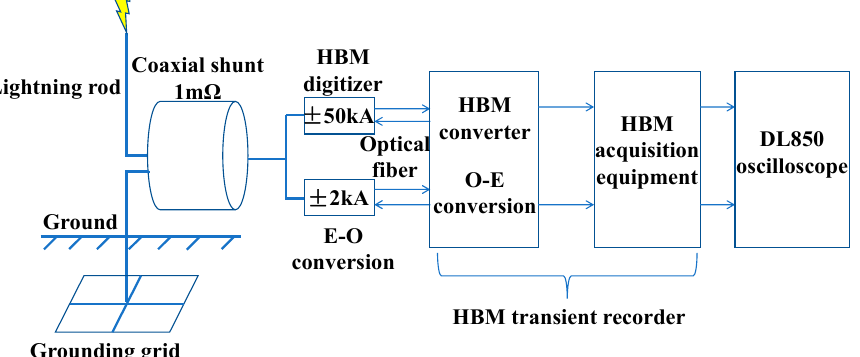
Figure 1. Schematic diagram of the direct measurement of the lightning current.